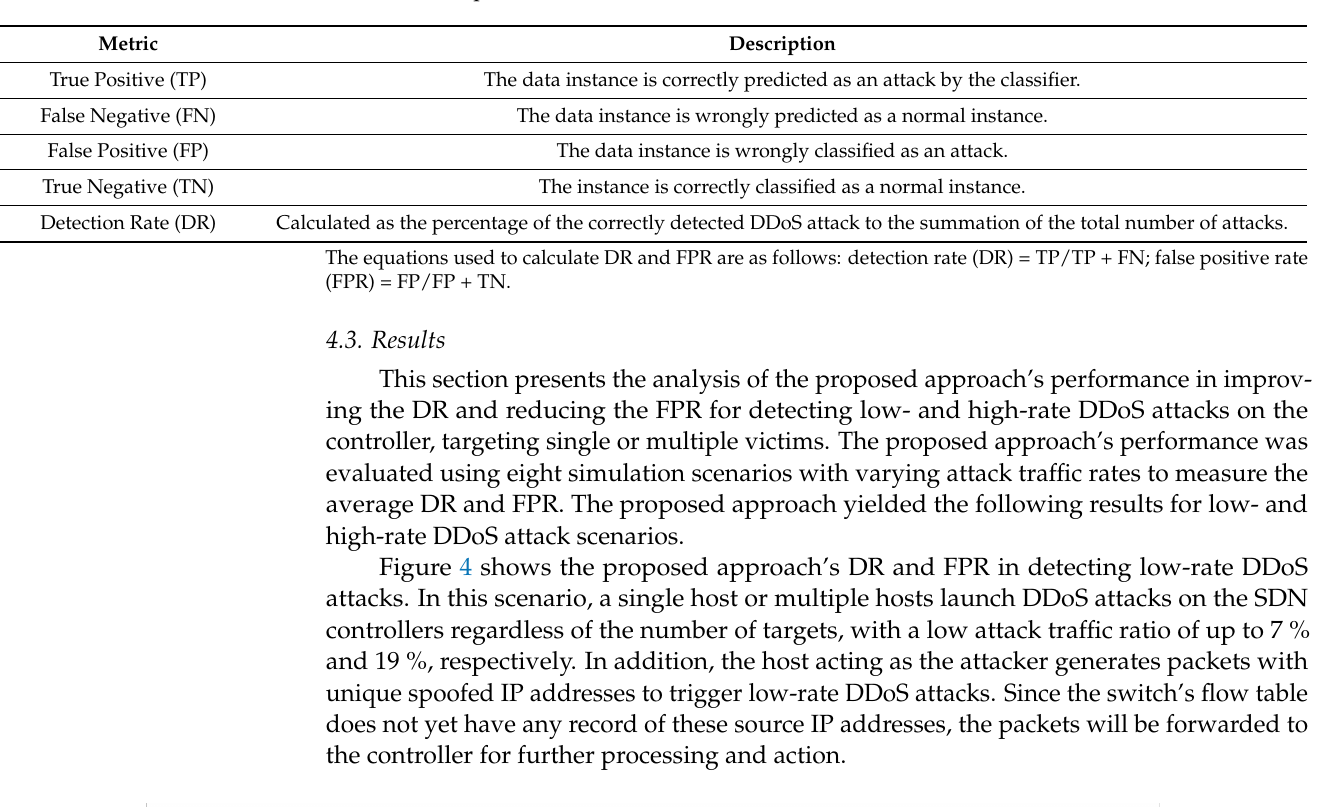
Table 4. Description of confusion matrix attributes.